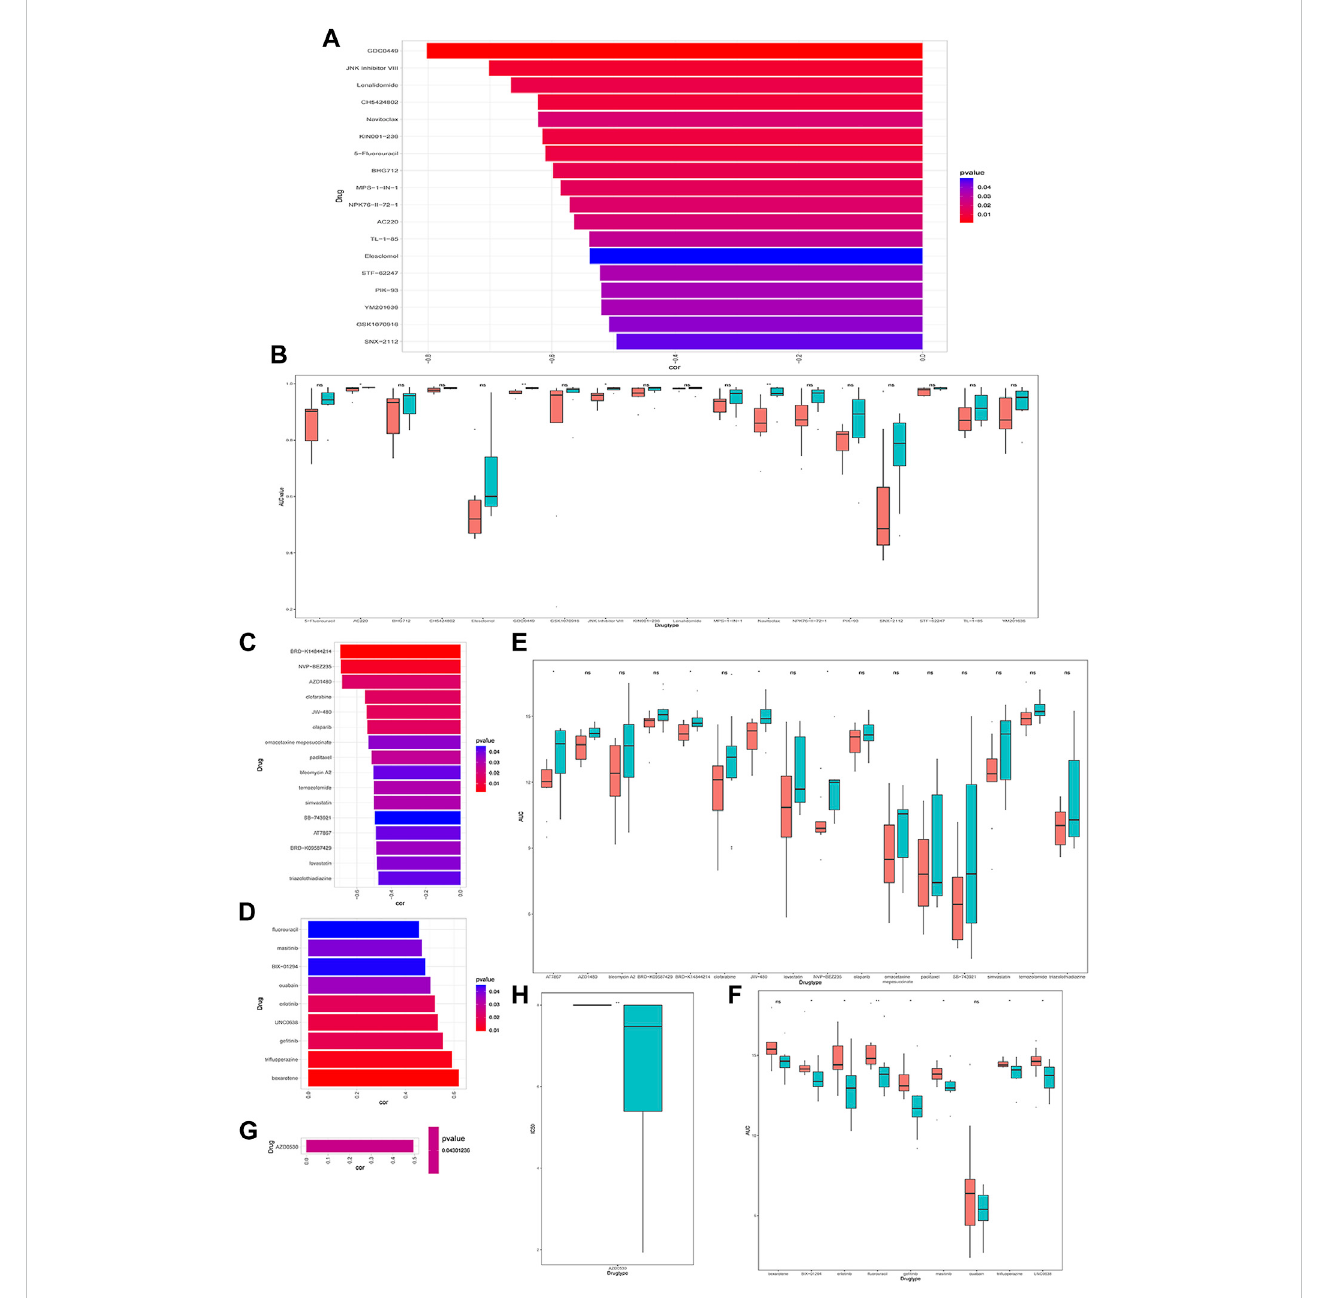
FIGURE 8 Drug sensitivity analysis of cuproptosis-related genes (CRGs)signature groups in Genomicsof Drug Sensitivity in Cancer (GDSC), Cancer Cell Line Encyclopedia(CCLE) andCancer Therapeutics Response Portal(CTRP) databases. (A) Correlations betweenCRGs score anddrug area underthecurve(AUC) inGDSC( p < 0.05 wasselected); (B) CRGs signatureof eachcell lineunderdifferentdrugtreatmentswith signi fi cantnegativecorrelationinGDSC database (* represents p < 0.05, ** represents p < 0.01, *** represents p < 0.001). (C) Correlations between CRGssignature and drug AUC in CTRP database ( p < 0. 05 and drug display with negative correlation were selected). (D) Correlations between CRGs signature and drug AUC in CTRP database (select p < 0.05 and positivecorrelateddrugs); (E) TheCRGssignatureofeachcelllineunderdifferentdrugtreatmentswithsigni fi cantnegativecorrelations inCTRPdatabase(ns: p > 0.05;*: p < 0.05); (F) ThedifferencesintheCRGssignatureofeachcell lineunderdifferentdrug treatments withsigni fi cant positivecorrelationinCTRP(ns: p > 0.05; *: p < 0.05; **: p < 0.01); (G) The correlations between the CRGs signature in CCLE database and the IC50 of drugs ( p < 0.05 and positive correlations were selected); (H) The differences in the CRGs signature of each cell line under different drug treatments with signi fi cant positive correlations in CCLE (*represents p < 0.05; *represents p < 0.01; **represents p <